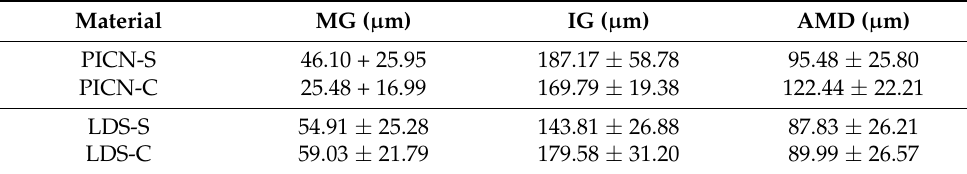
Table 1. Mean ± SD of MG, IG, and AMD of PICN and LDS crowns (n = 10).